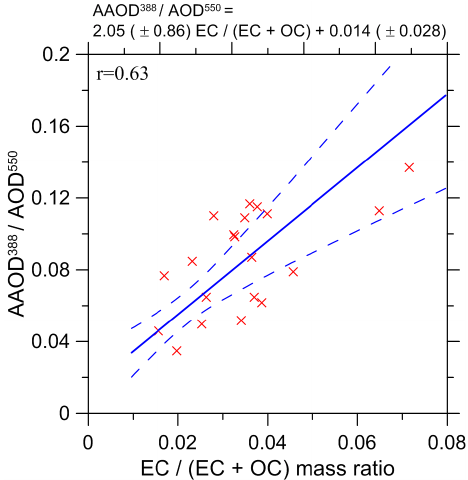
Figure 9. The ratio of absorption and extinction AOD at 388 nm and 550 nm, respectively, as a function of the EC/(EC + OC) mass ratio. Both ratios were evaluated in this study using AERONET observations. A linear regression (fitted with the ODR method) and the 90% confidence intervals of the fit are shown by solid and dashed lines, respectively.